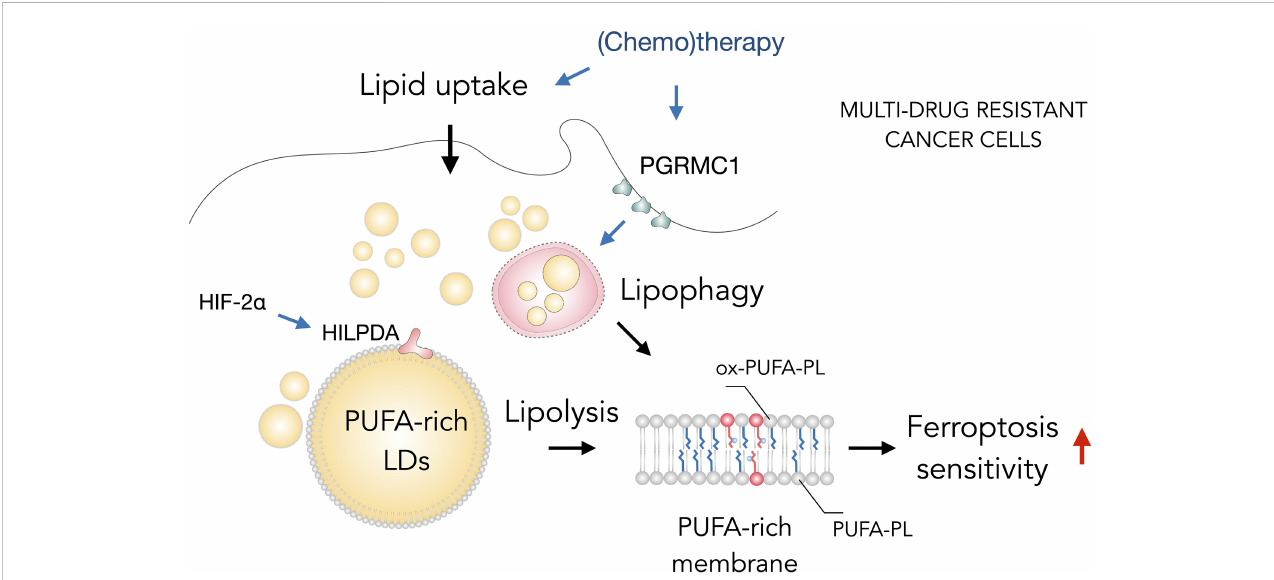
FIGURE 4 Lipid droplets (LDs) sensitize drug-resistant cancer cells to ferroptosis. The acquisition of multidrug resistant states in cancer cells is accompanied by widespread metabolic remodeling and activation of various signaling pathways, including increased lipid uptake, progesterone receptor membrane component 1 (PGRMC1) overexpression and activation of the hypoxia-inducible factor 2 alpha (HIF-2 α )/hypoxia-inducible LD-associated protein (HILPDA) axis, which promote the accumulation of polyunsaturated fatty acid (PUFA)-enriched triglycerides and cholesteryl esters stored within LDs. These LDs may contribute through lipolysis and lipophagy to the enrichment of membrane phospholipids with PUFAs (PUFA-PLs). PUFA-PLs are easily oxidized during oxidativestressgivingrisetovariousoxidizedphospholipidspecies(ox-PUFA-PLs)thatimpairmembranefunctionandmayfurtherpropagatemembranelipid peroxidation, which can sensitize cells to